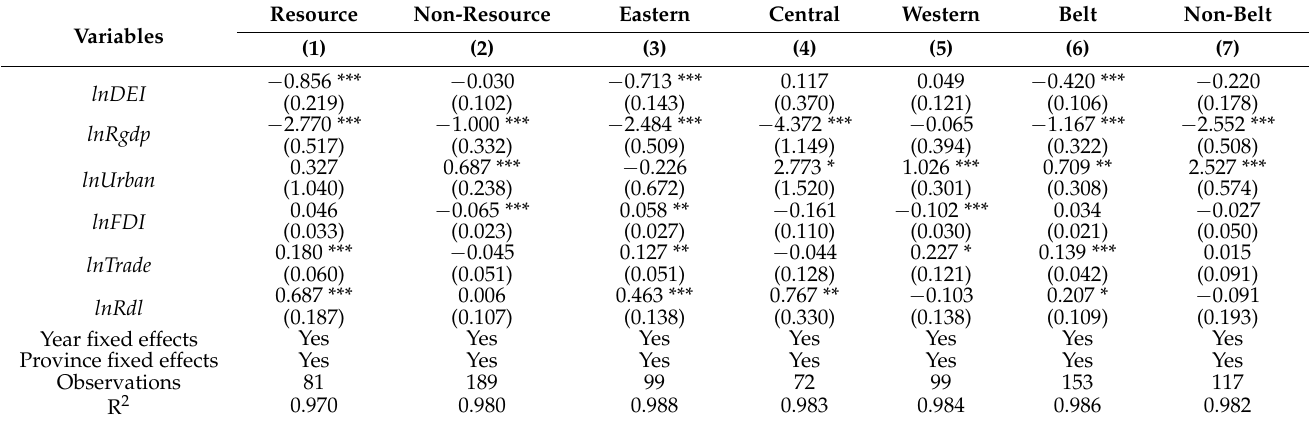
Table 7. Heterogeneous effect of digital economy on carbon emission